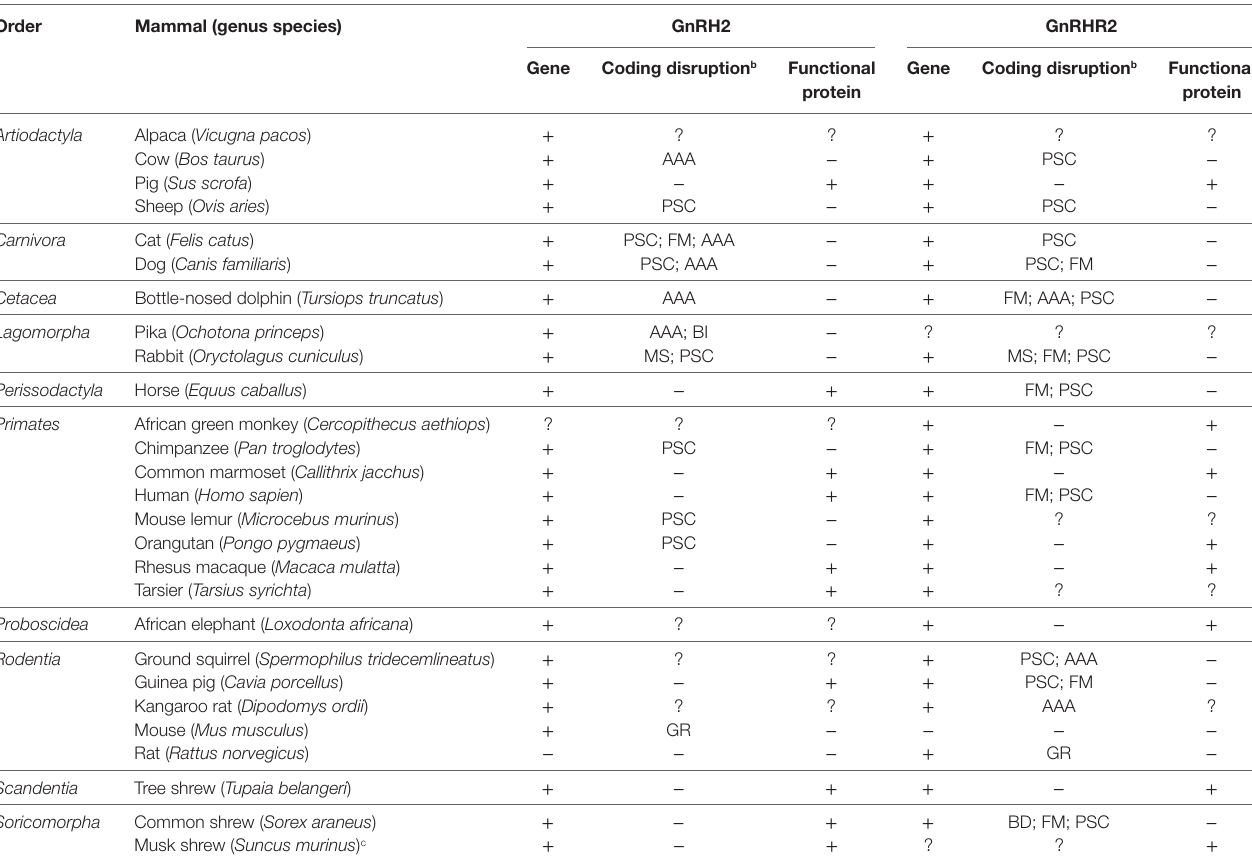
TABLe 1 | Presence and potential functionality of the GnRH2 and GnRHR2 genes within mammals. a